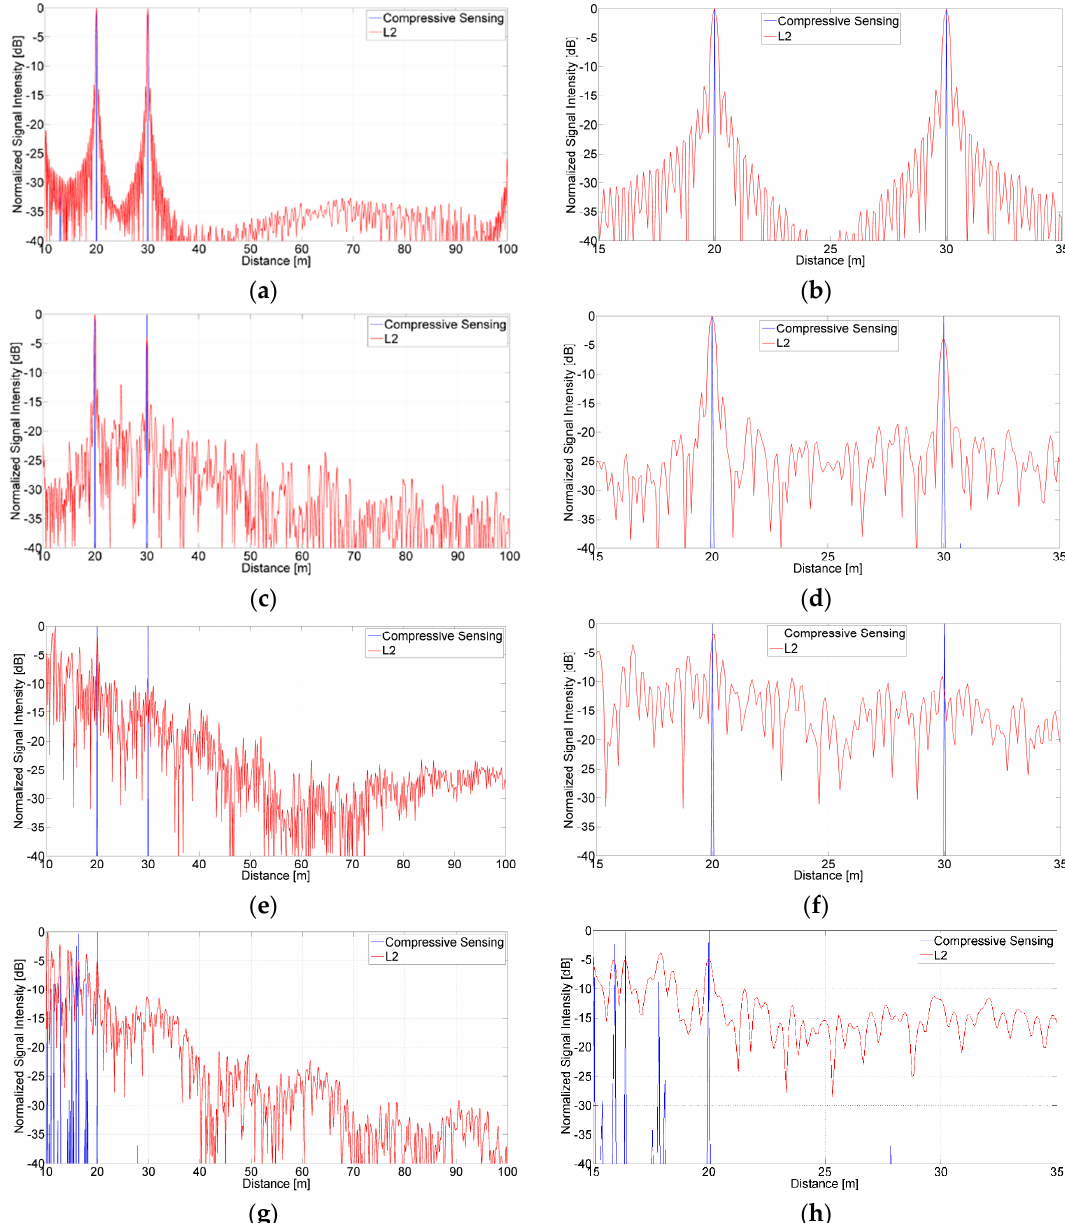
Figure 5. In depth focusing results, with 500 ( a ); 100 ( c ); 20 ( e ) and 10 ( g ) frequencies sampled in the 500 MHz bandwidth. Enlargements related to the 15–35 m range are reported in ( b ), ( d ), ( f ) and ( h ). Results of proposed technique (blue line) are compared with the L 2 -norm ones (red line). The target range distances are 20 and 30 m, respectively.